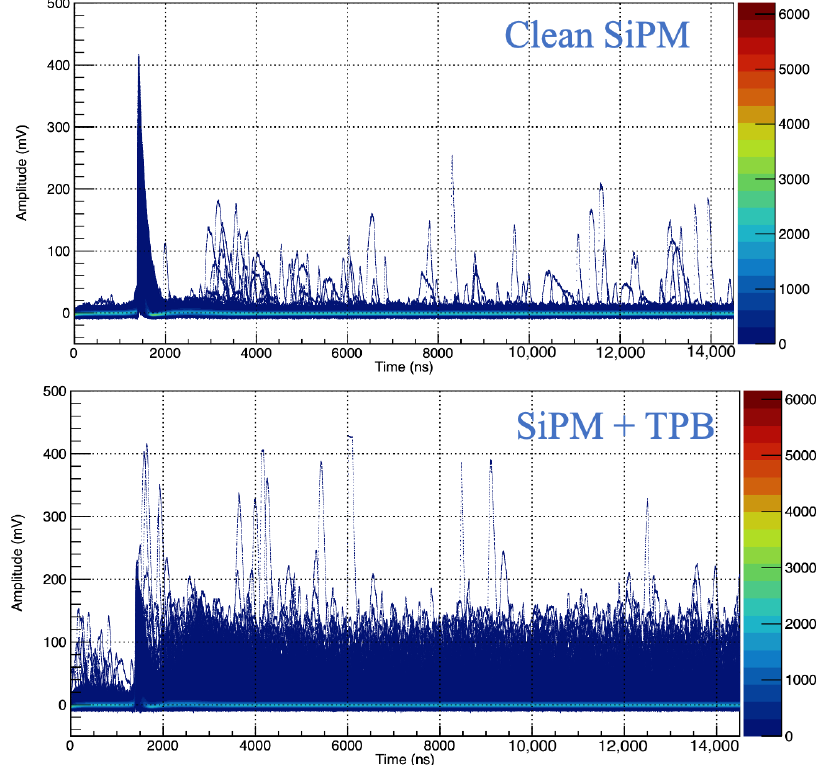
Figure 5. The overlaid signals measured with the clean ( top ) and TPB-coated ( bottom ) SiPM looking at the light source under vacuum. The SiPMs were placed right across the MgF 2 window of the light source in a vacuum assembly. The data taking was triggered with the SiPM signals themselves slightly above the single avalanche threshold. The trigger was timed to be around 1500 ns and all the waveforms were overlaid to make the